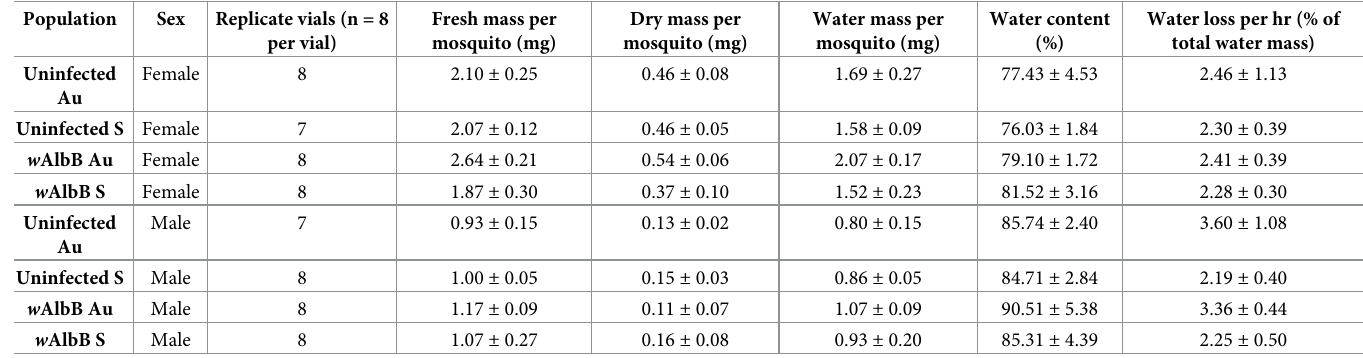
Table 3. Average mass and water loss in w AlbB-infected and uninfected Aedes aegypti adults from Australian and Saudi Arabian backgrounds under low relative humidity. Medians and standard deviations are shown for each trait. Population Sex Replicate vials (n = 8 per